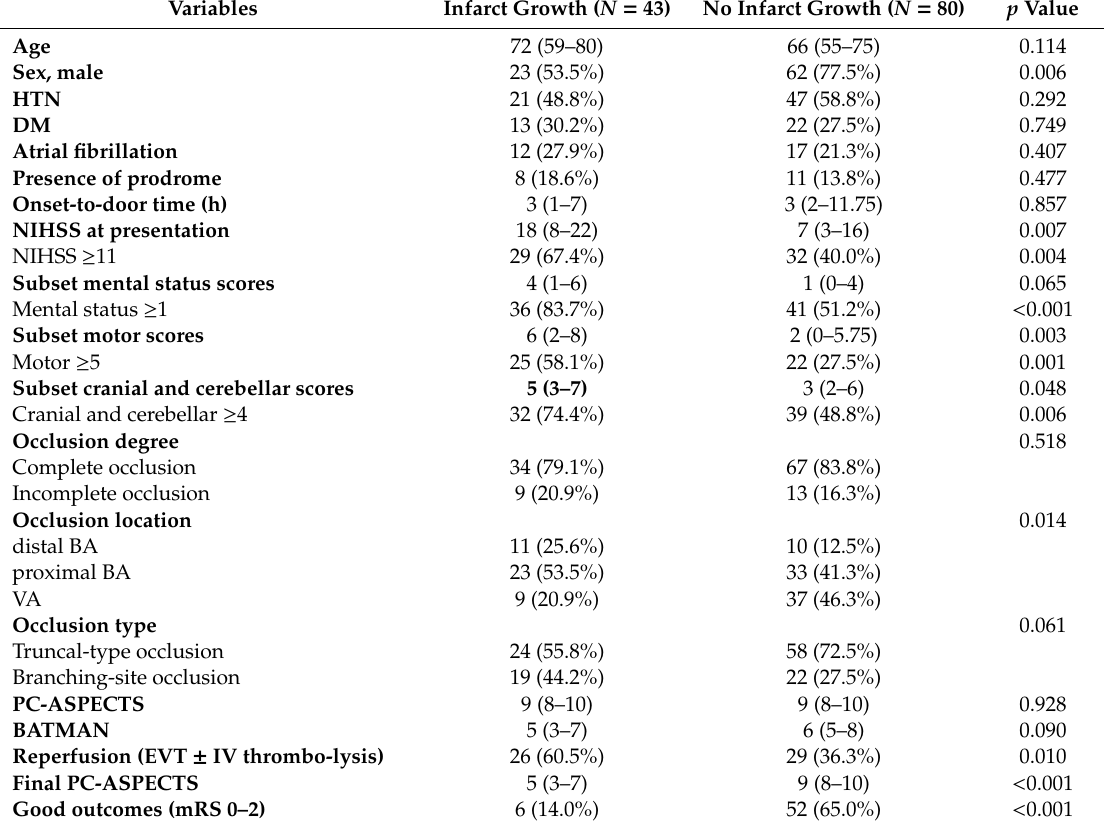
Table 1. Comparison of patients who experienced infarct growth and who did